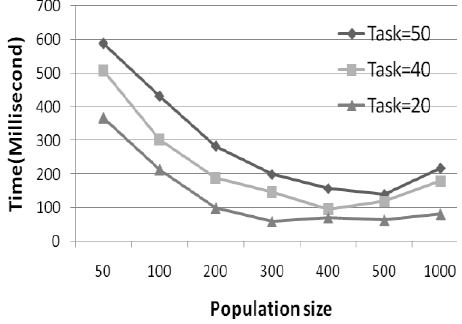
Figure 16. Impact of population number on the performance of algorithm (web service=100)